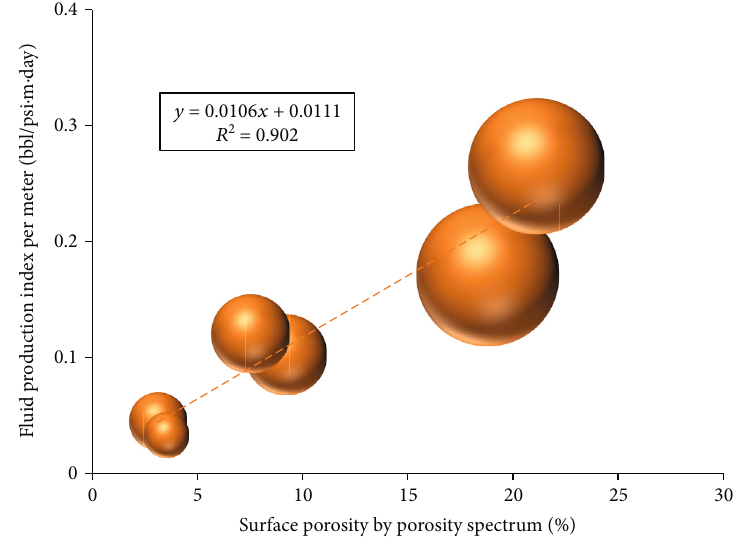
Figure 11: Intersection diagram of surface porosity by porosity spectrum and fl uid production index per meter in production layer